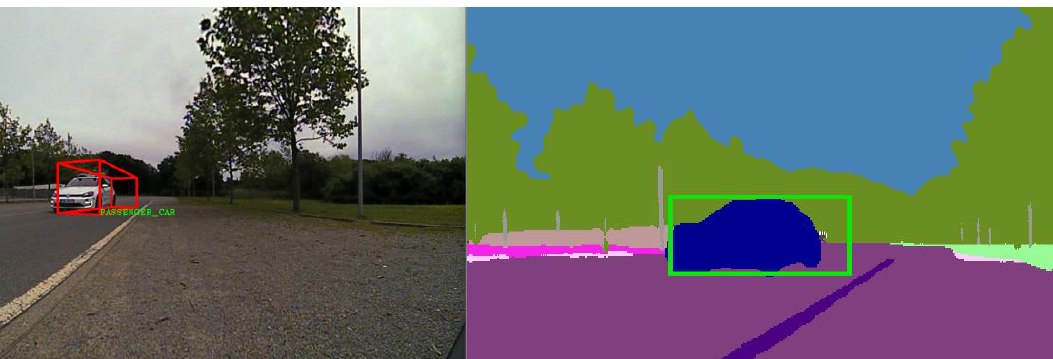
Figure 19. Example of successful validation. In the left image, the super-sensor object is projected onto the RGB image. In the right image, the same object is projected onto the semantic segmentation image. The semantic classes’ match is represented using green color.